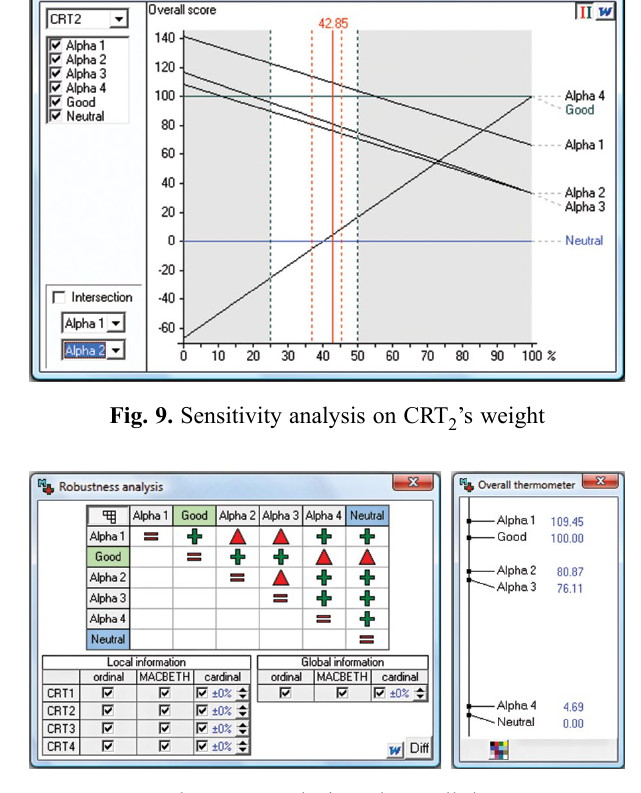
Fig. 10. Robustness analysis and overall